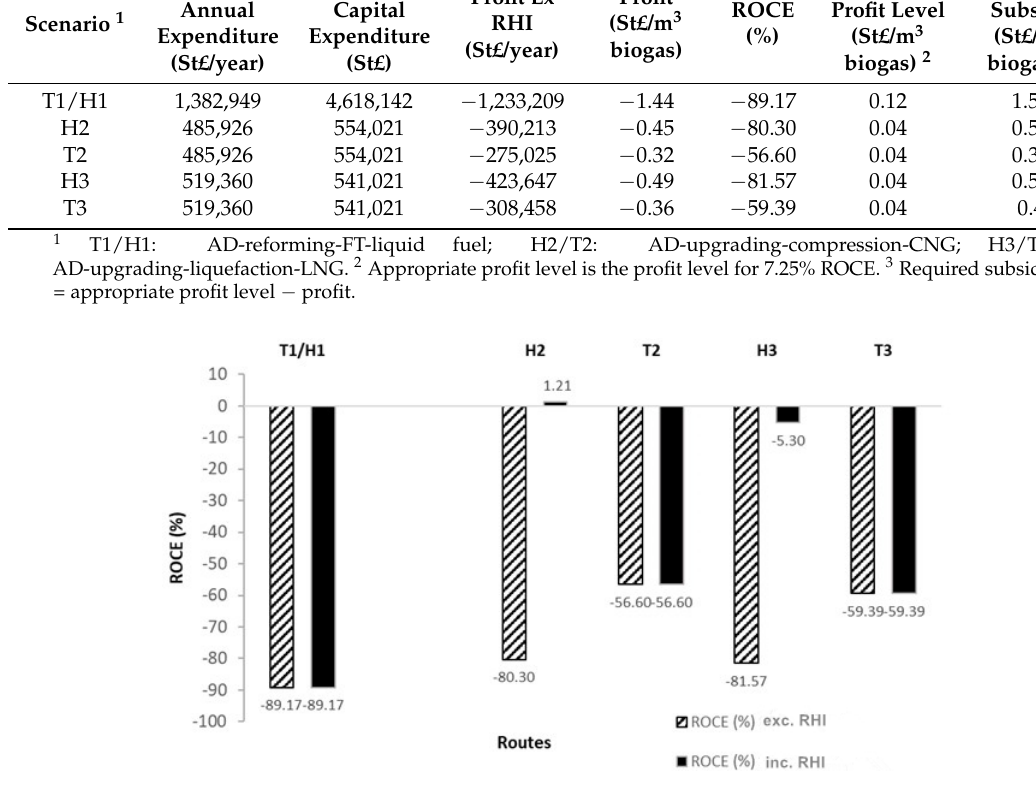
Figure 10. Return on capital employed (ROCE) for routes in the heat and transport